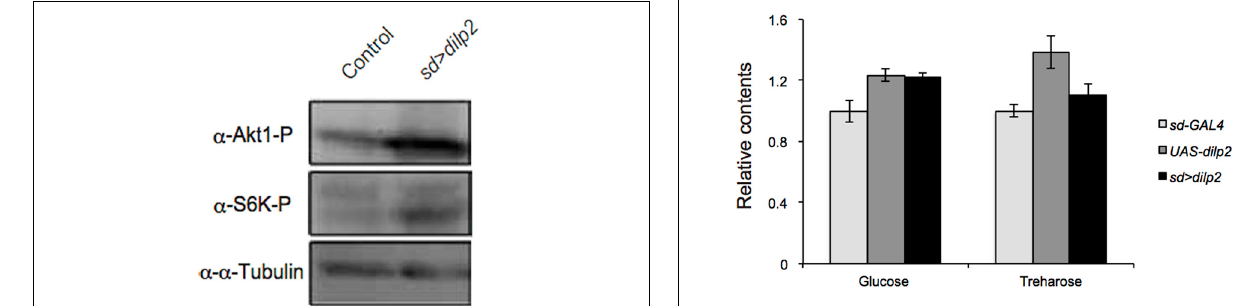
FIGURE 4 | Trehalose and glucose content in dilp2 -overexpressing flies. Relative amount of glucose and trehalose in the sd > dilp2 flies was calculated based on the values of a parental line ( sd-Gal4 ) and indicated as the mean ± SE of at least three samples with a minimum of five flies per group. There was no significant difference in the amount of these sugars.